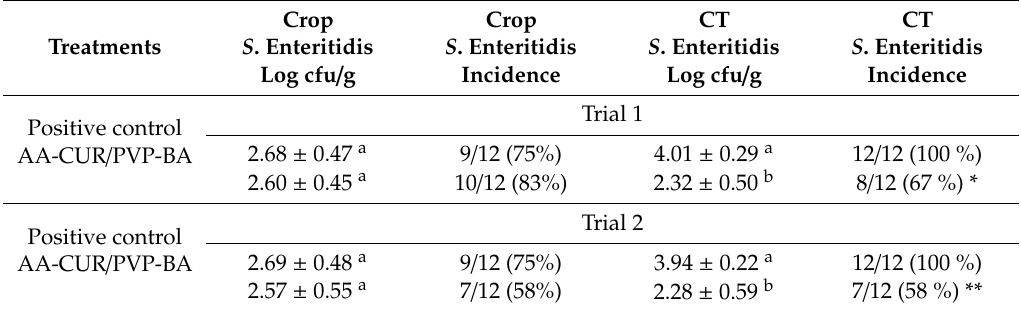
Table 2. Prophylactic administration of a 0.1% mixture containing ascorbic acid (AA) and a solid dispersion of curcumin with polyvinylpyrrolidone (CUR / PVP, ratio 1:9) and boric acid (BA) (AA-CUR / PVP-BA) on crop and cecal tonsils (CT) colonization of Salmonella Enteritidis ( S . Enteritidis) 1 in broiler chickens (Experiment